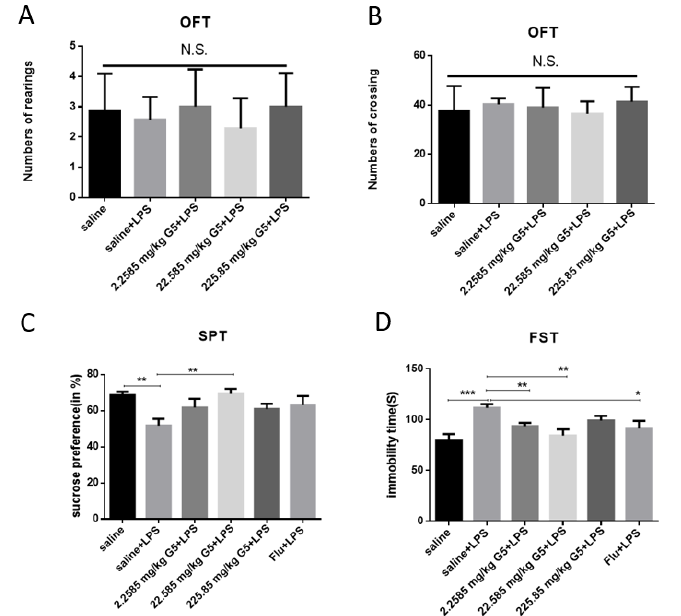
Figure 3. Effects of GPR1 on depression-like behaviors. ( A , B ) OFT was assessed before the SPT and FST. ( C ) The SPT was measured 24 h after LPS injection. ( D ) The FST was performed 24 h after LPS injection. For statistical significance, N.S., not significant; * p < 0.05, ** p < 0.01, *** p < 0.005 for one-way ANOVA followed by Fisher’s least significant difference test; n = 7, all data are presented as mean ± SEM.